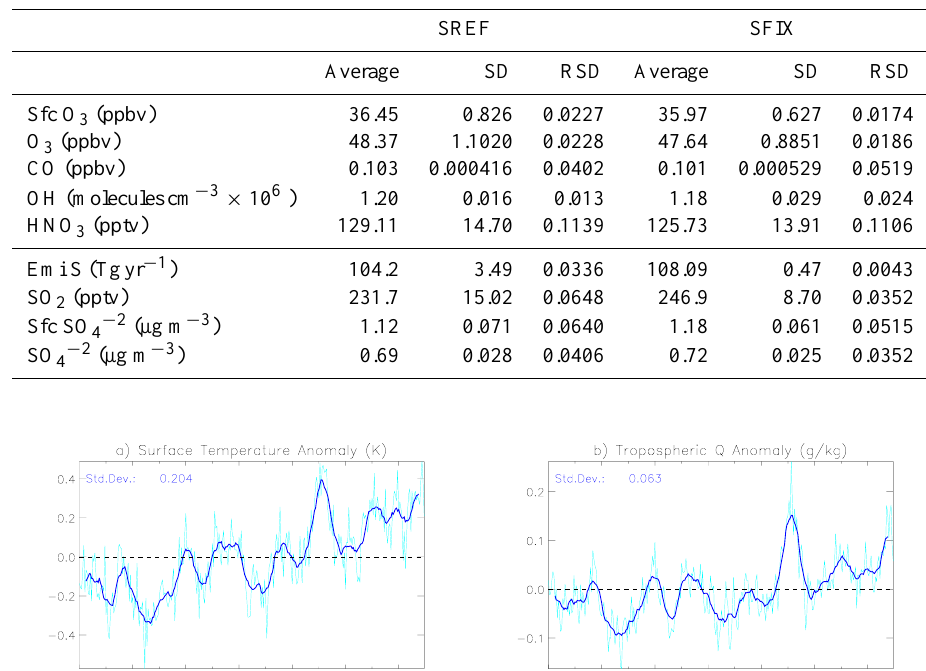
Table 2. Average, standard deviation (SD) and relative standard deviation (RSD, standard deviation divided by the mean) of globally averaged variables in this work for the simulation with changing anthropogenic emission and with fixed anthropogenic emissions (1980–2005). Three dimensional variables are density weighted and averaged between the surface and 280hPa. Three dimensional quantities evaluated at the surface are prefixed with Sfc. The standard deviation is calculated as the standard deviation of the monthly anomalies (the monthly value minus the mean of all years for that month).